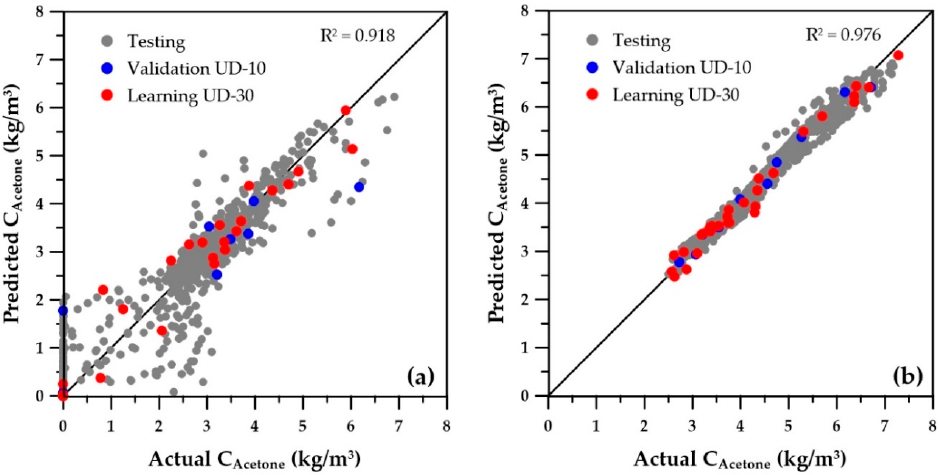
Figure 5. Predicted versus actual butanol concentration within the fermenter under steady state for ( a ) initial ranges and ( b ) reduced ranges of the five decision variables.